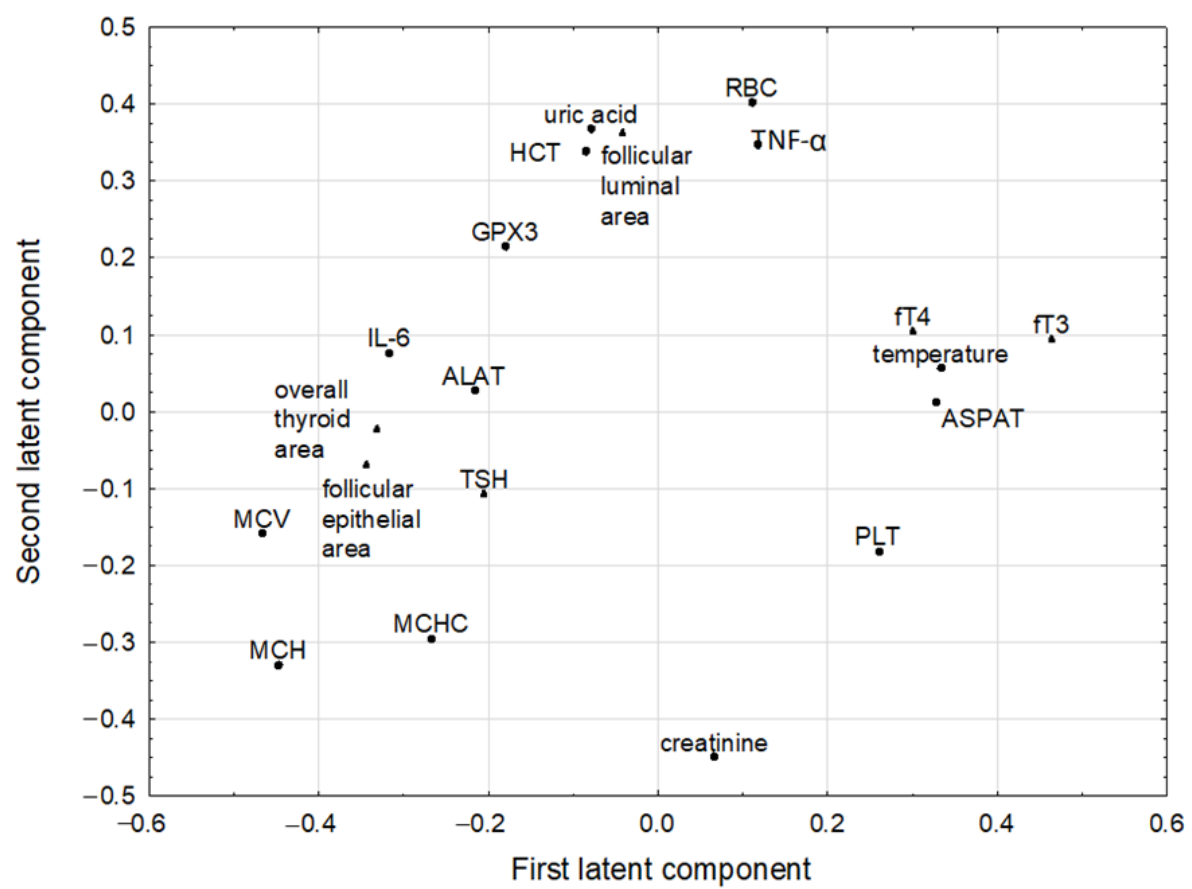
Figure 2. The loadings for first two latent component of PLS model (the predictive parameters are indicated by dots and the response parameters by triangles), see Section 2. for the explanation of all abbreviations. Table 5. Correlation weights for the pairs of parameters based on PLS model (only the first fifteen correlation weights with highest absolute values were shown), see Section 2. for the explanation of all abbreviations.